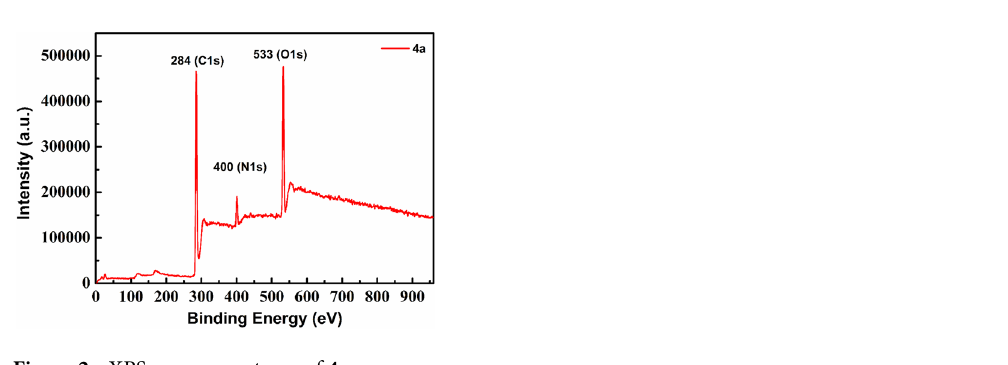
Figure 2. XPS survey spectrum of 4a